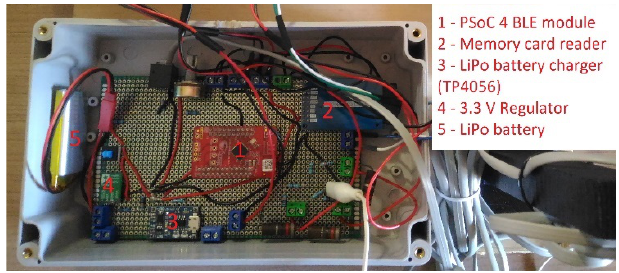
Figure 9. Detail of the developed electronics included in the prototype of the weather station.